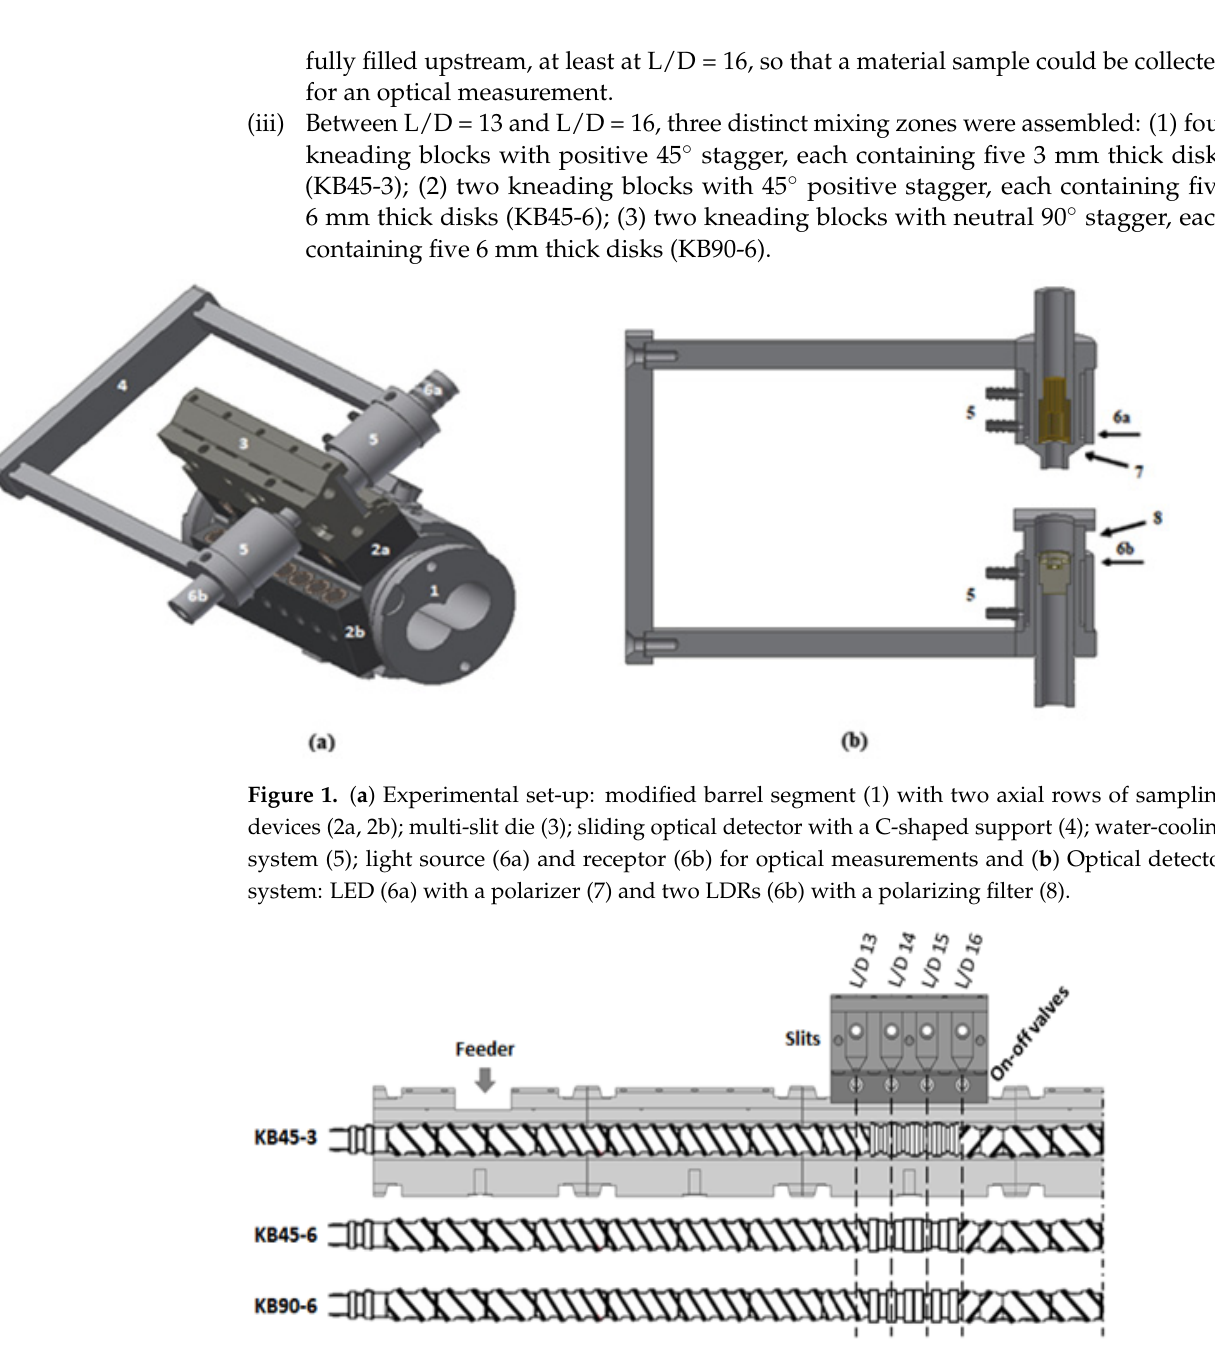
Figure 2. Screw profiles containing a 60 mm long mixing zone with different geometries: KB45-3— four kneading blocks with positive 45° stagger, each containing five 3 mm thick disks; KB45-6—two kneading blocks with 45° positive stagger, each containing five 6 mm thick disks; KB90-6—two kneading blocks with neutral 90° stagger, each containing five 6 mm thick disks.